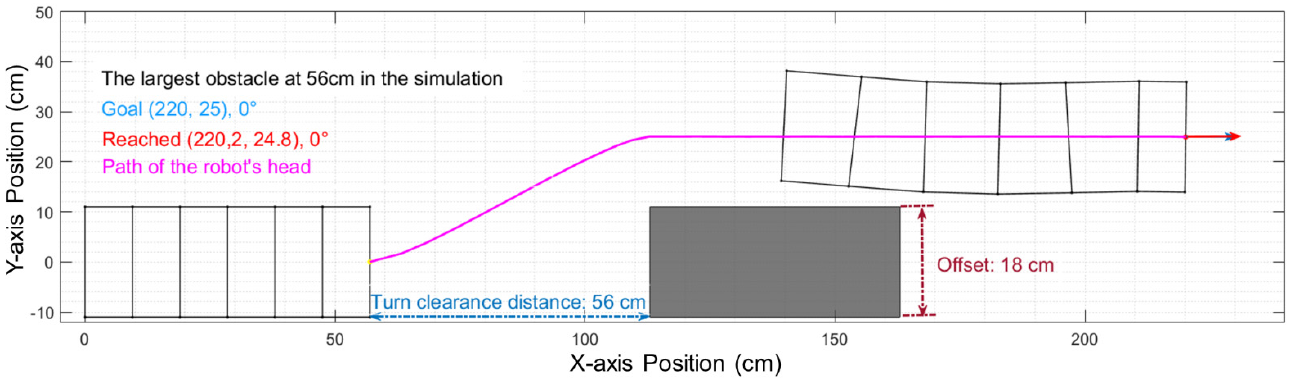
Figure 15. With the application of an 80% scale factor for correction, the simulation can more accurately predict the results of the real-world implementation.